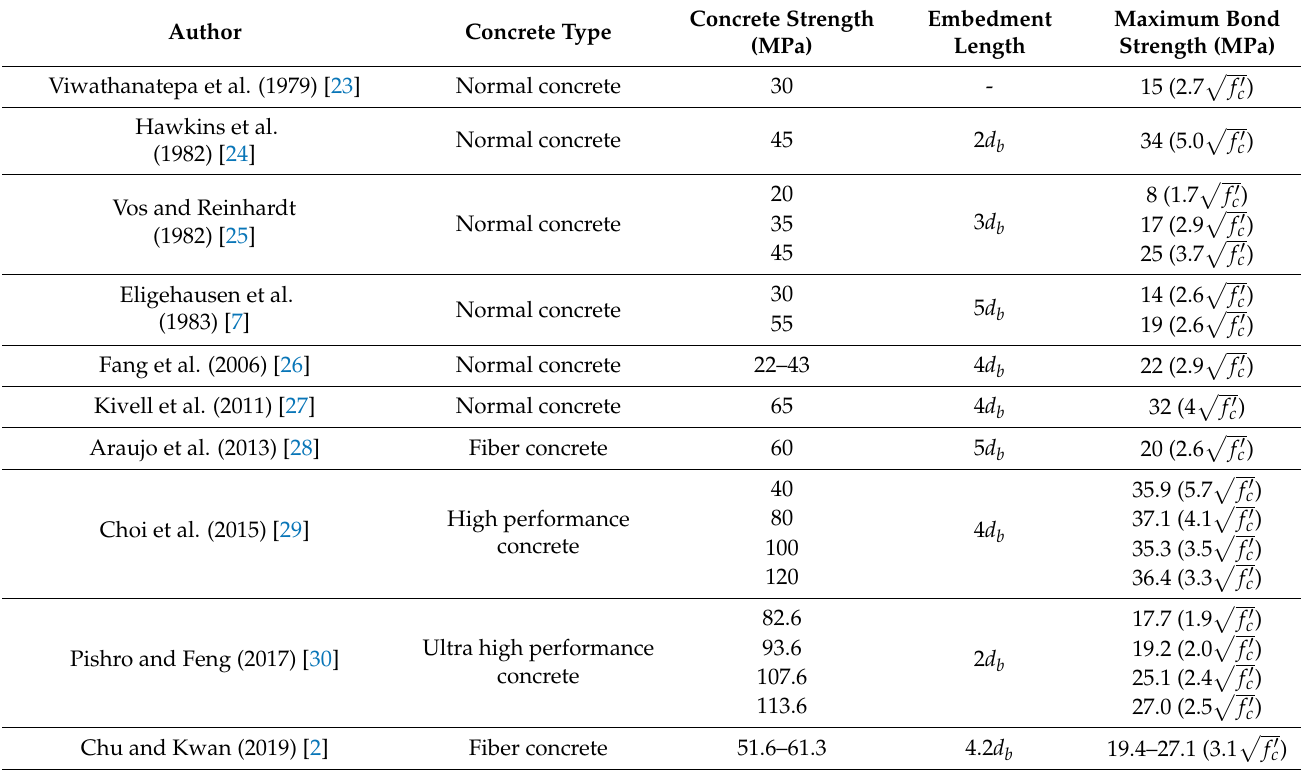
Table 2. General results for the maximum “local” bond strength in pull-out tests.